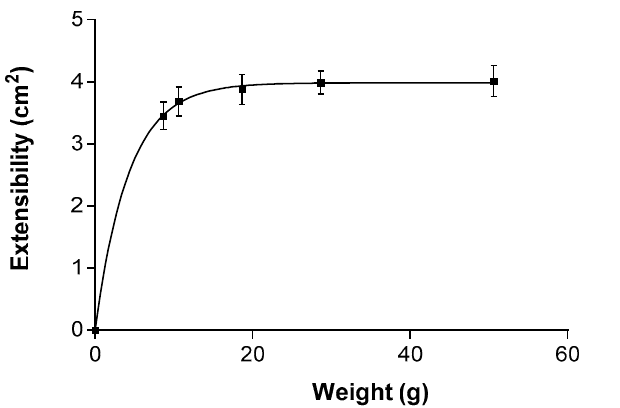
Figure 7. Fitting of PF-NLCs-N6 for the extensibility at 25 ± 2 °C; 60% ± 5% RH ( n = 3). The extensibility followed a first-order model.